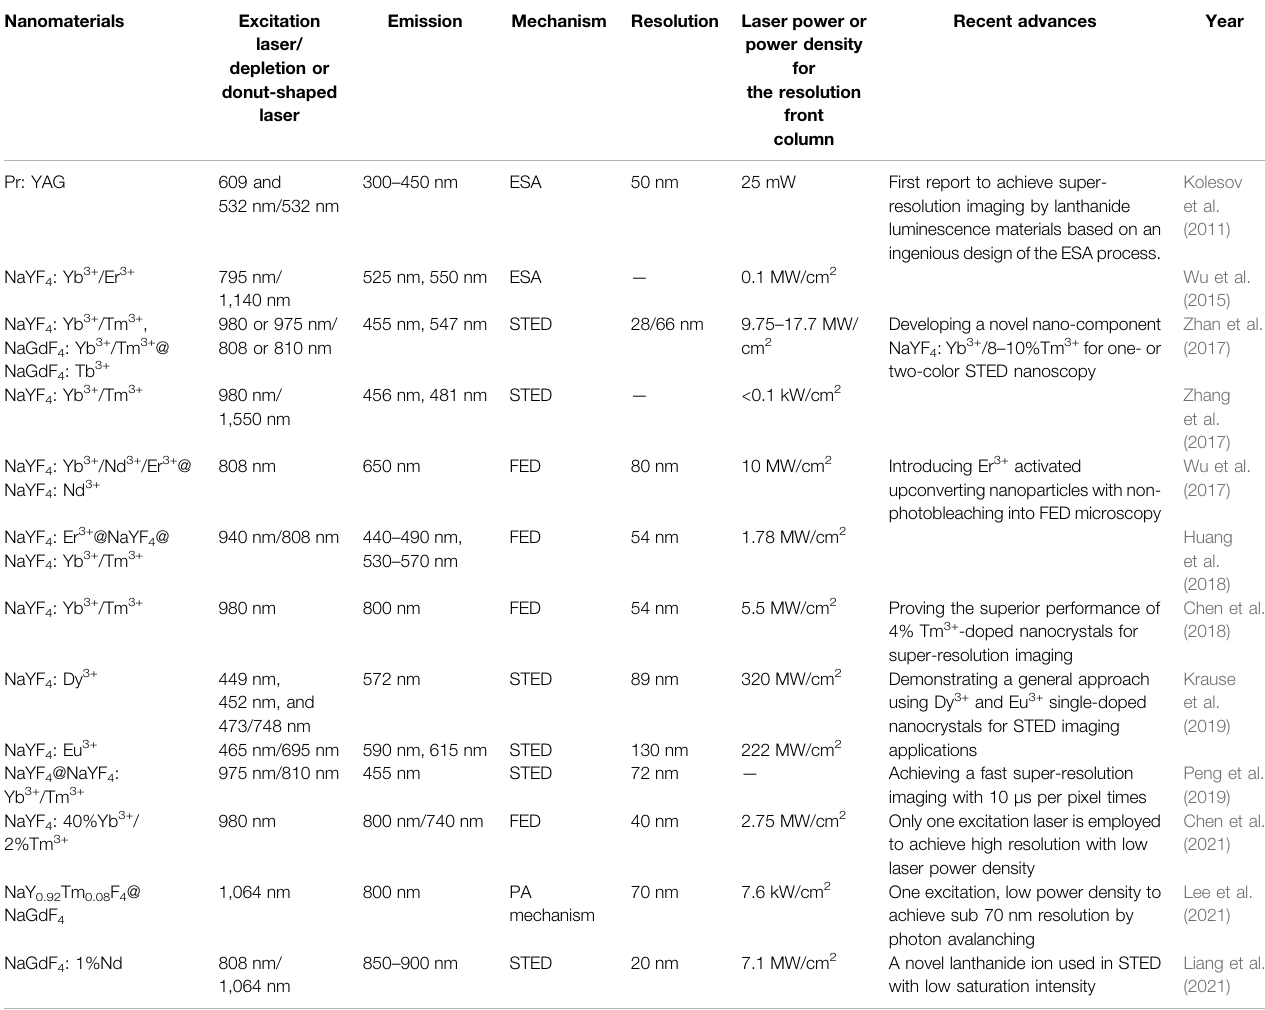
TABLE 1 | Progress in the design and results of lanthanide-doped nanocrystals for super-resolution imaging.